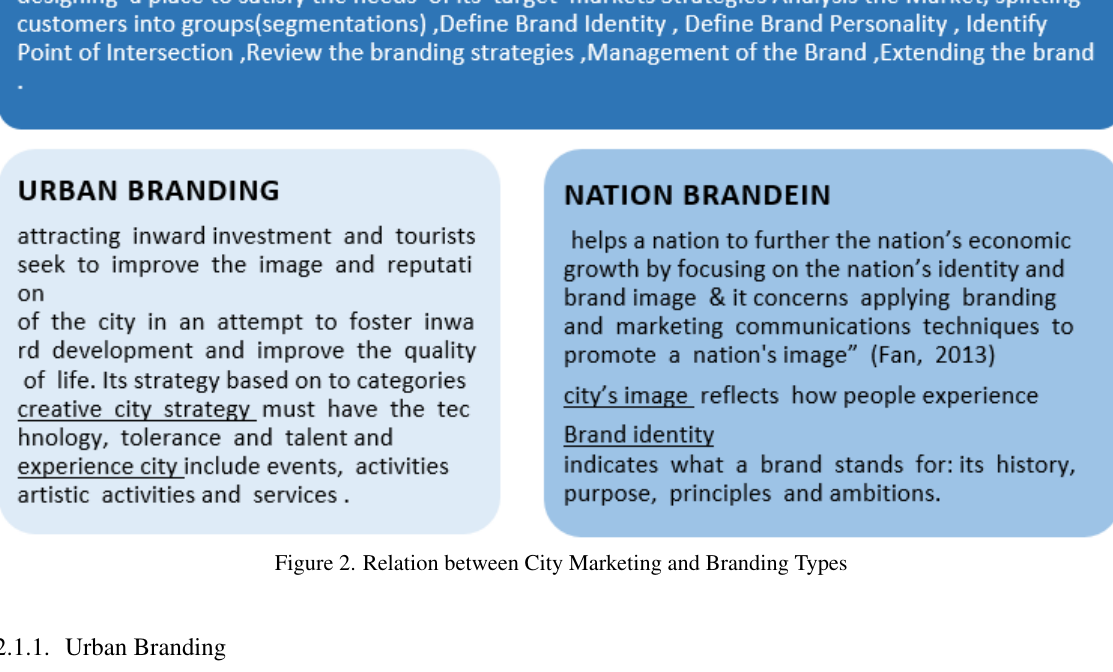
Figure 2. Relation between City Marketing and Branding